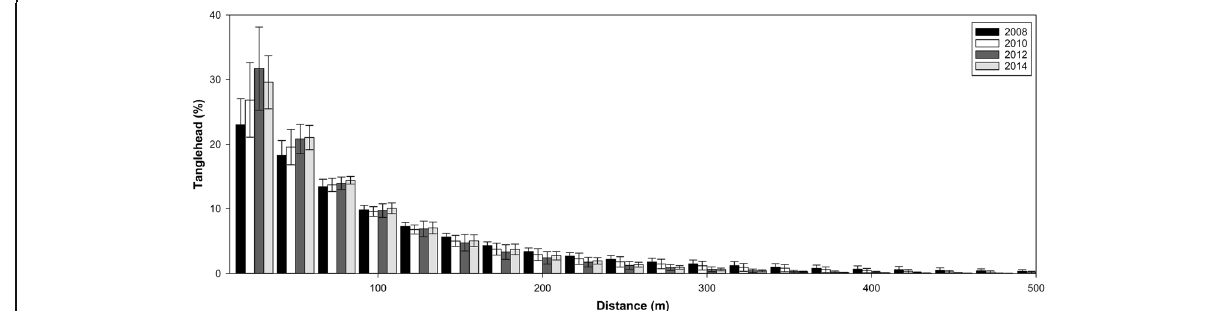
Fig. 3 Percentage of tanglehead in relation to the distance from roads between 2008 and 2014 in Jim Hogg and Duval Counties in the Coastal Sand Sheet of South Texas, USA. Error bars represent standard